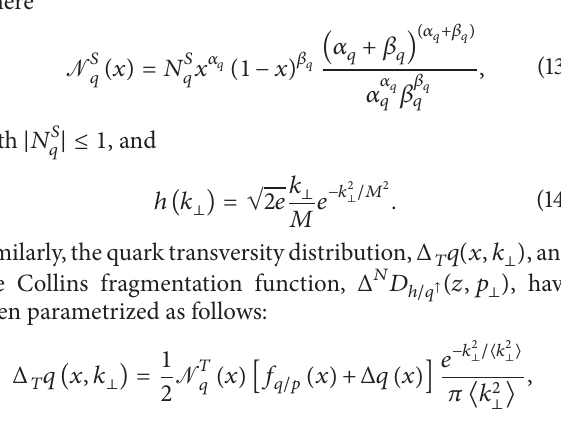
and 𝜋 0 production in 𝑝𝑝 ↑ → 𝜋𝑋 processes, computed according to (6)–(8) of the text. The contributions from the Sivers and the Collins effects are added together. The computation is performed adopting the Sivers and Collins functions of [20, 22] (SIDIS 1-KRE, left panels) and of [21, 23] (SIDIS 2-DSS, right panels). The overall statistical uncertainty band, also shown, is the envelope of the two independent statistical uncertainty bands obtained following the procedure described in Appendix A of